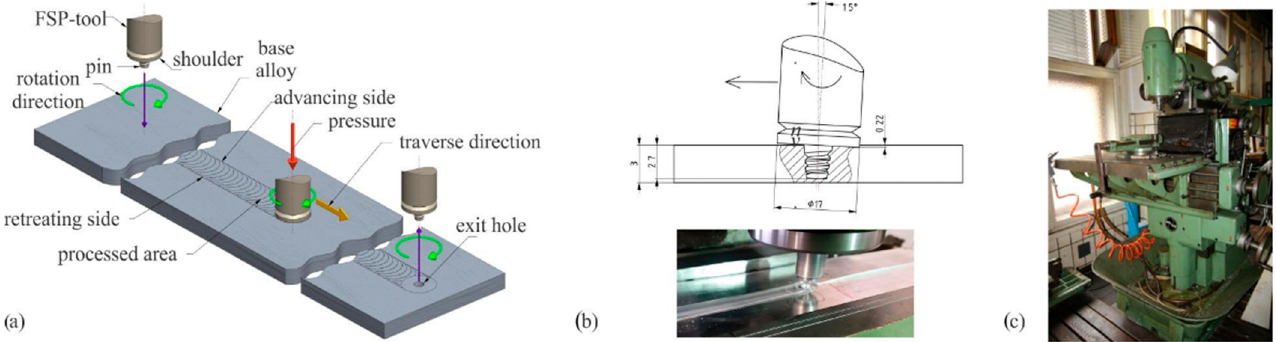
Figure 1. Friction stir processing: ( a ) schematic drawing of FSP, ( b ) drawing of the applied pin, and ( c ) the equipment used for FSP.